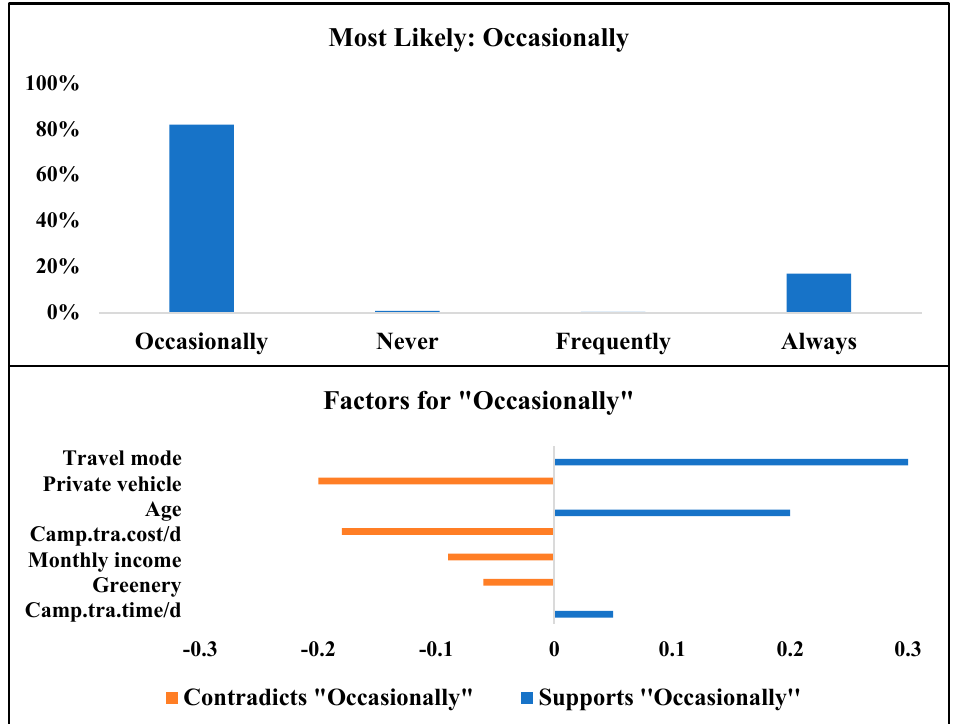
Figure 17. Optimization results and importance of variables based on the second scenario: Occasionally use SFFESs.